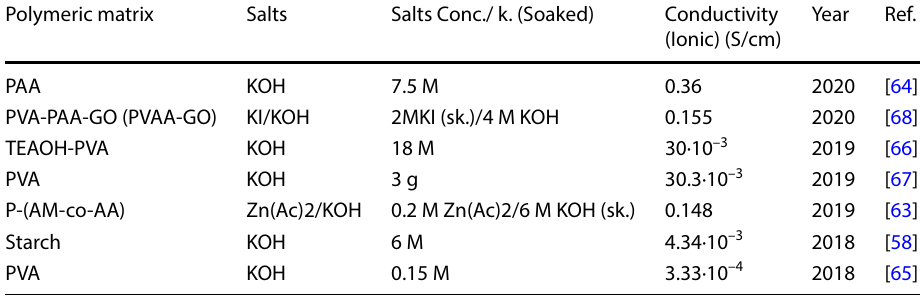
Ac stands for acetate, sk for